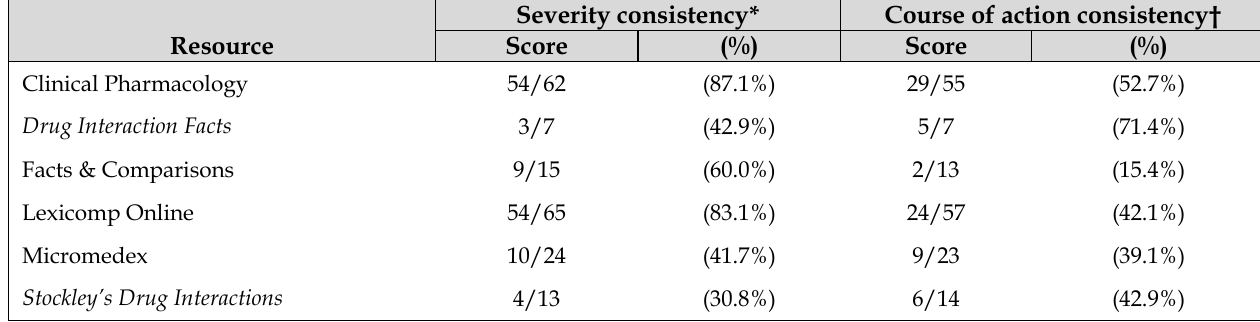
Table 3 Consistency scores by